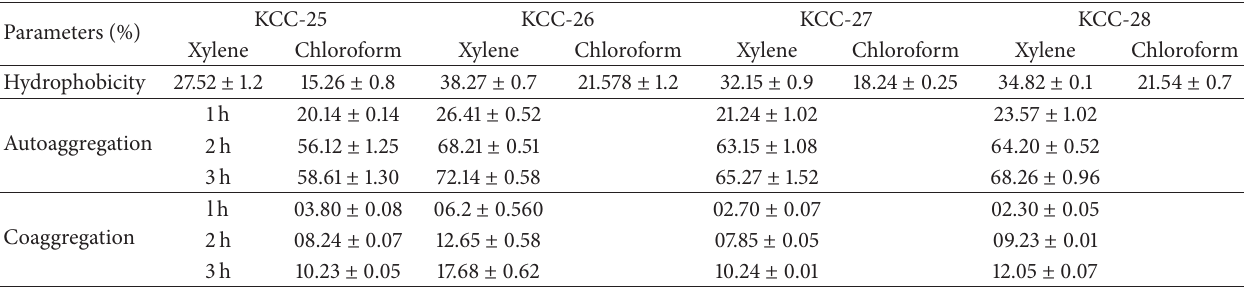
Table 5: Cell surface hydrophobicity and aggregation properties of Lactobacillus